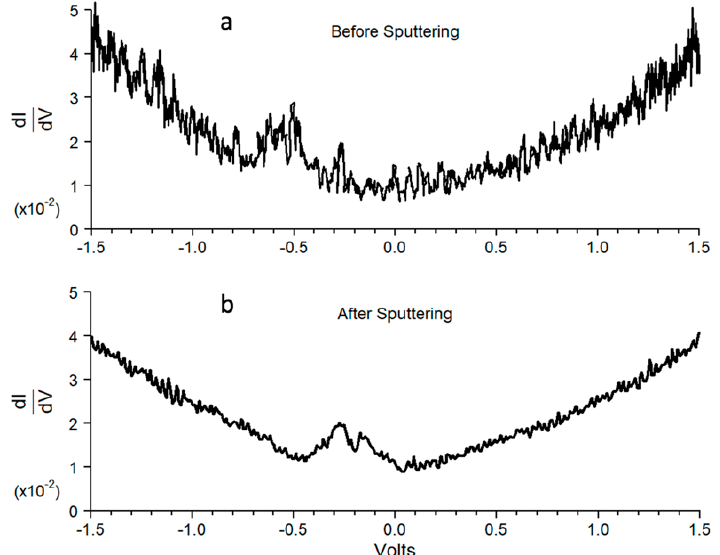
Figure 7. Direct measurements of the DOS, both occupied and unoccupied, about the Fermi edge by scanning tunneling spectroscopy (STS). The top STS spectra ( a ) are of a sample that was not sputtered while the bottom spectra, ( b ) are of a sample after GCIS.